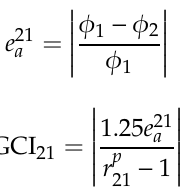
Table 2. Numerical uncertainty assessment and GCI (Grid Convergence Index) calculation.